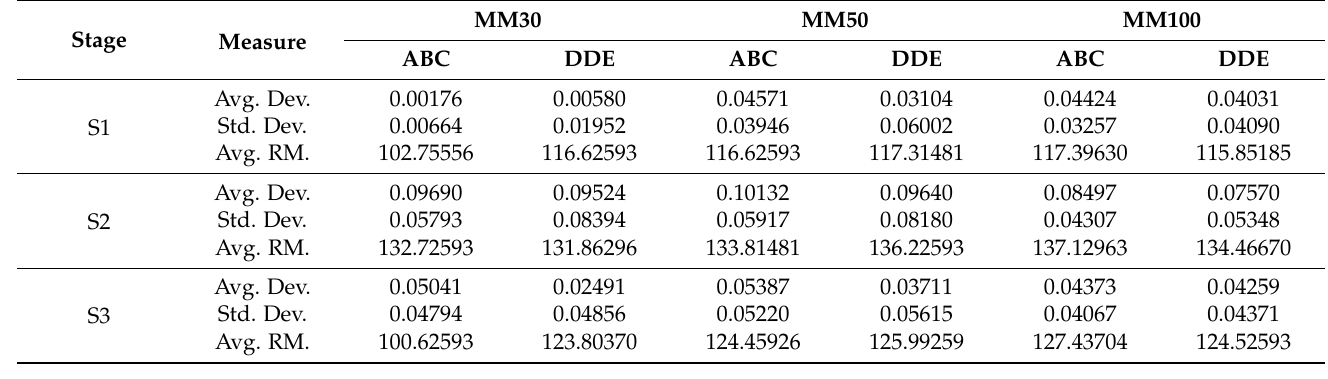
Table 7. Summary results for the MRCPSP/Max benchmark evaluations for each algorithm.